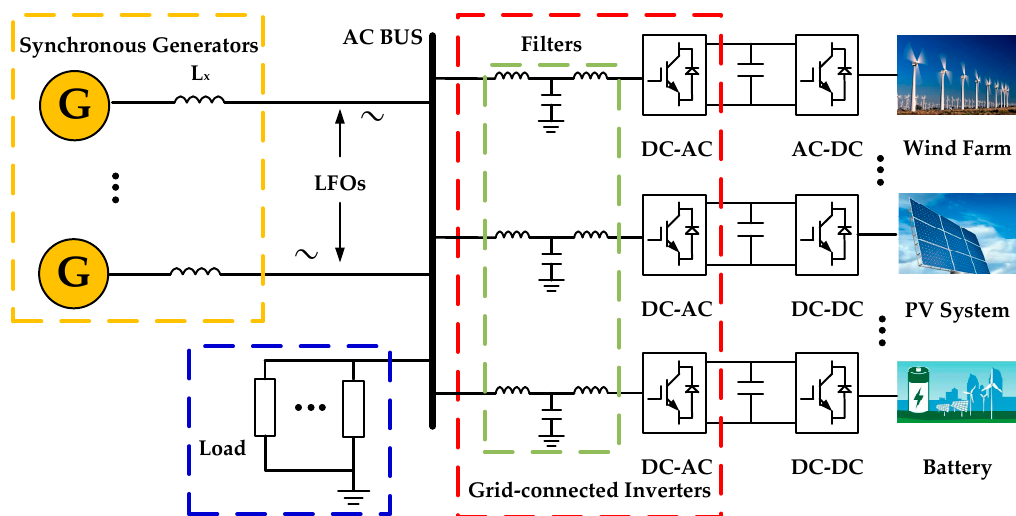
Figure 2. A typical set up of power electronics-based AC power system.